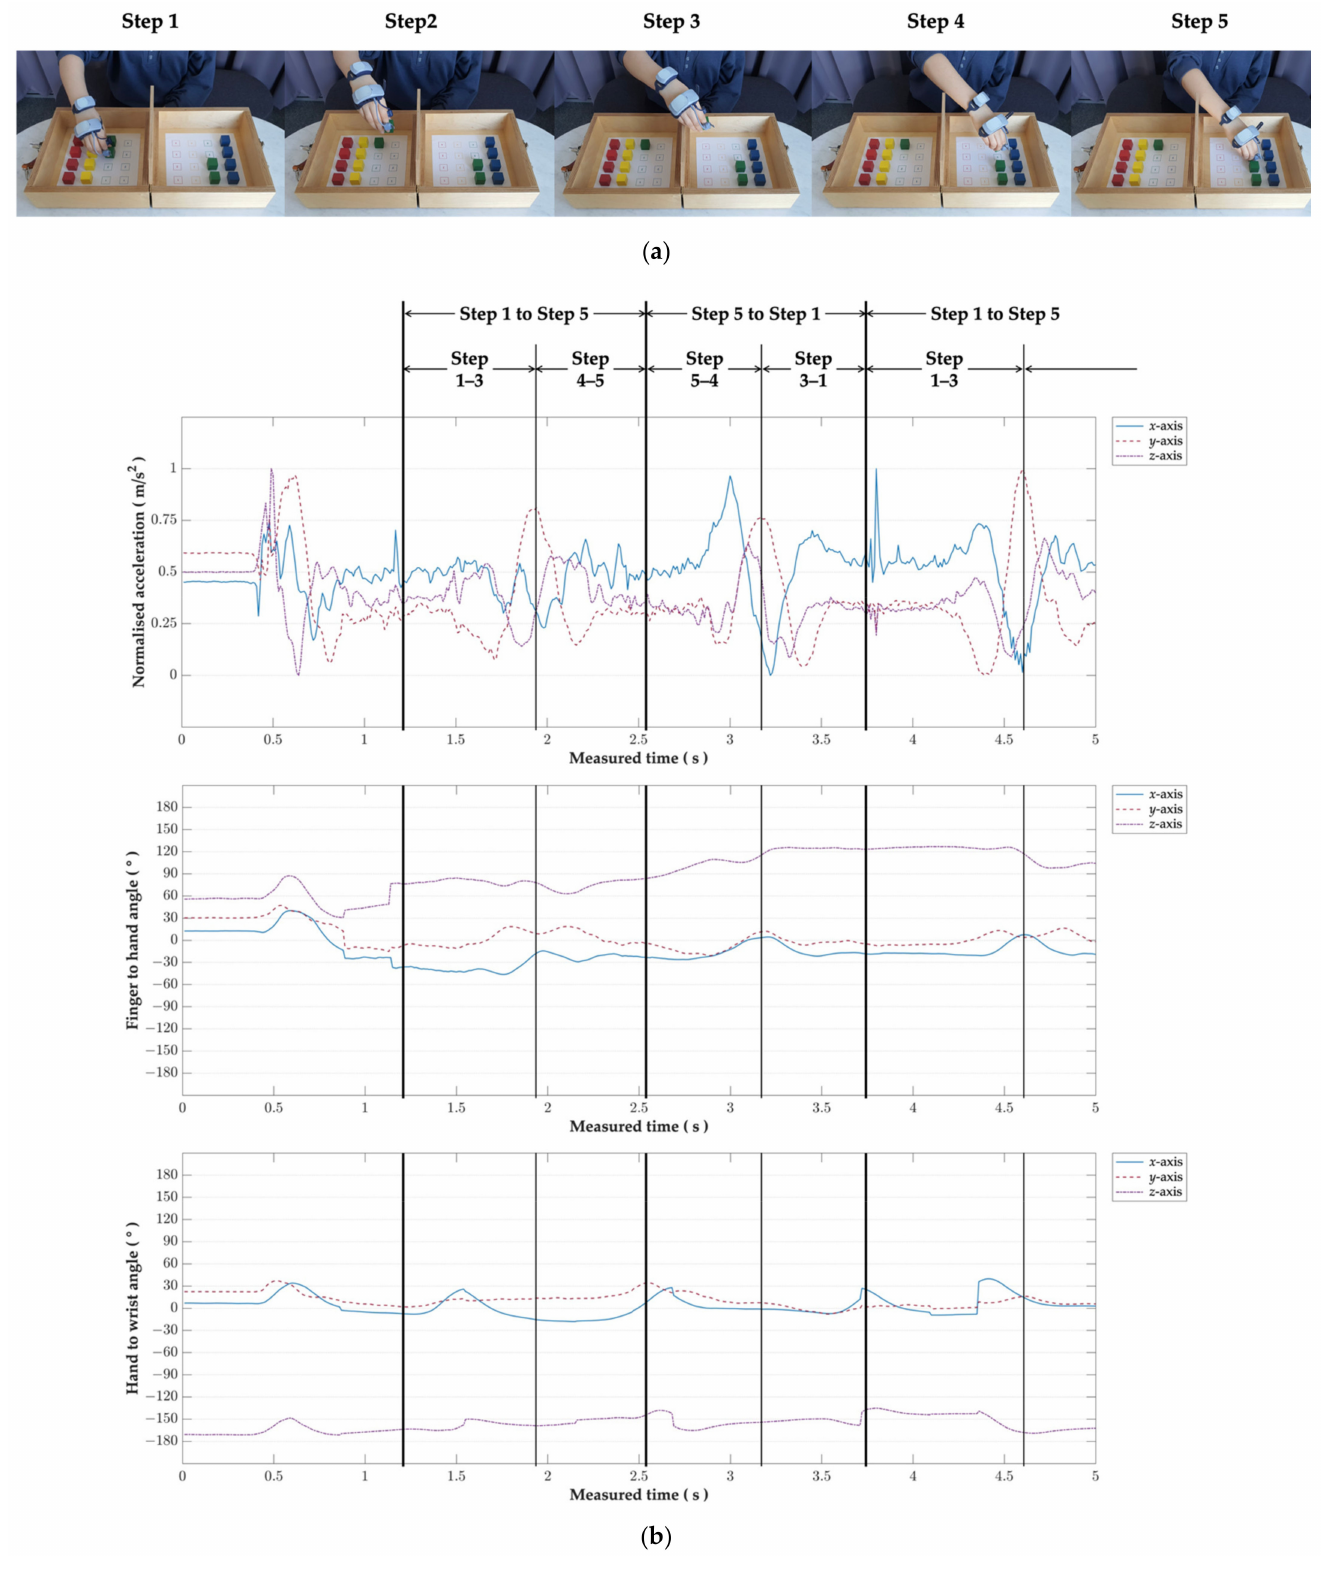
Figure 3. Hand movement sequences in Experiment 1: a targeted box and blocks test. ( a ) Motion sequence depiction in 5 steps; ( b ) IMU sensor output graph and intervals where the five-step motion sequence